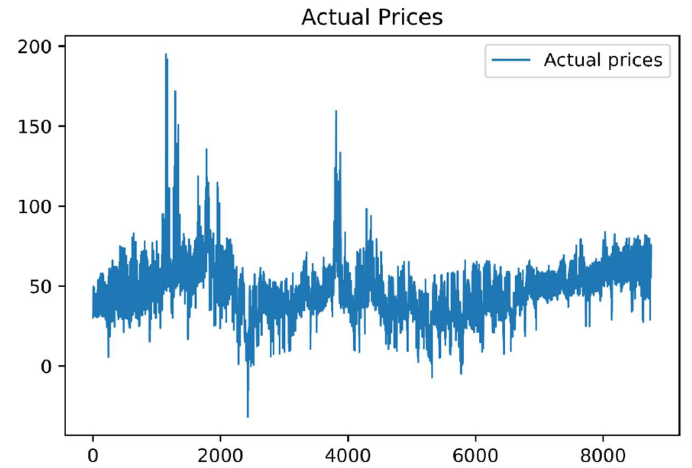
Figure 8. Actual price curve on the test set (from 22 September 2017 to 21 September 2018, 8760 h).